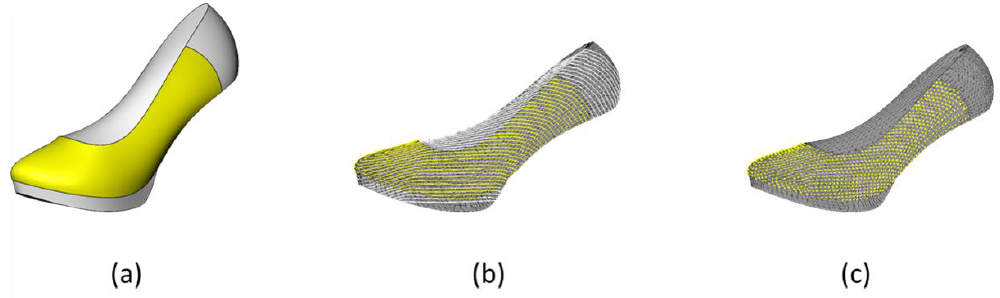
Figure 12. ( a ) Virtual reality modeling language (VRML) model of a high-heeled shoe; ( b ) offset curves generated by the OCPP; ( c ) theoretical filling result.